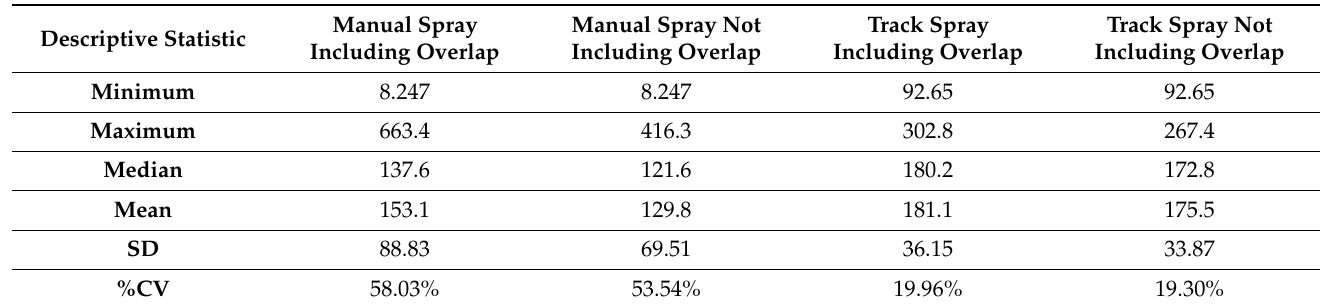
Table 2. Descriptive statistics for manual vs. track spraying using fluorescein. Results are given both with and without swath overlap